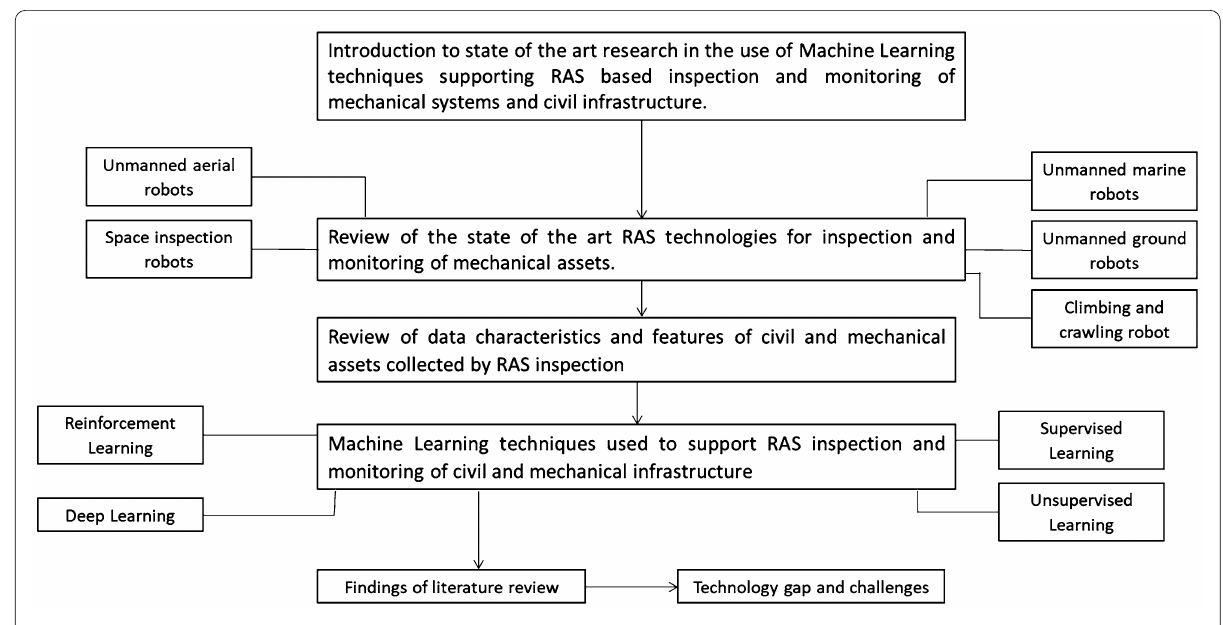
Figure 1 Schematic illustration of organization for the literature